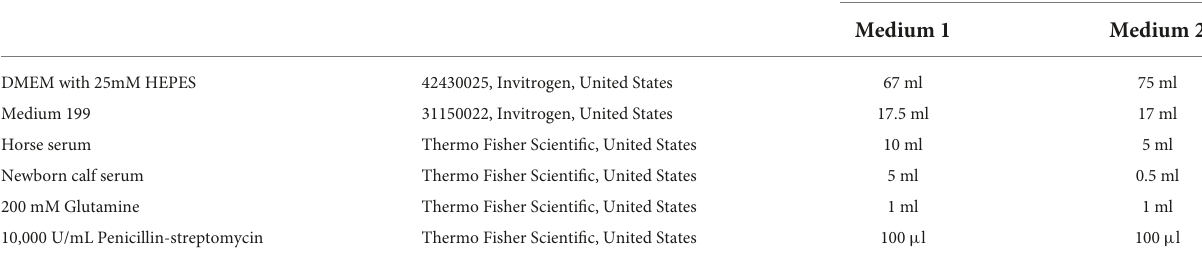
TABLE 2 Media for